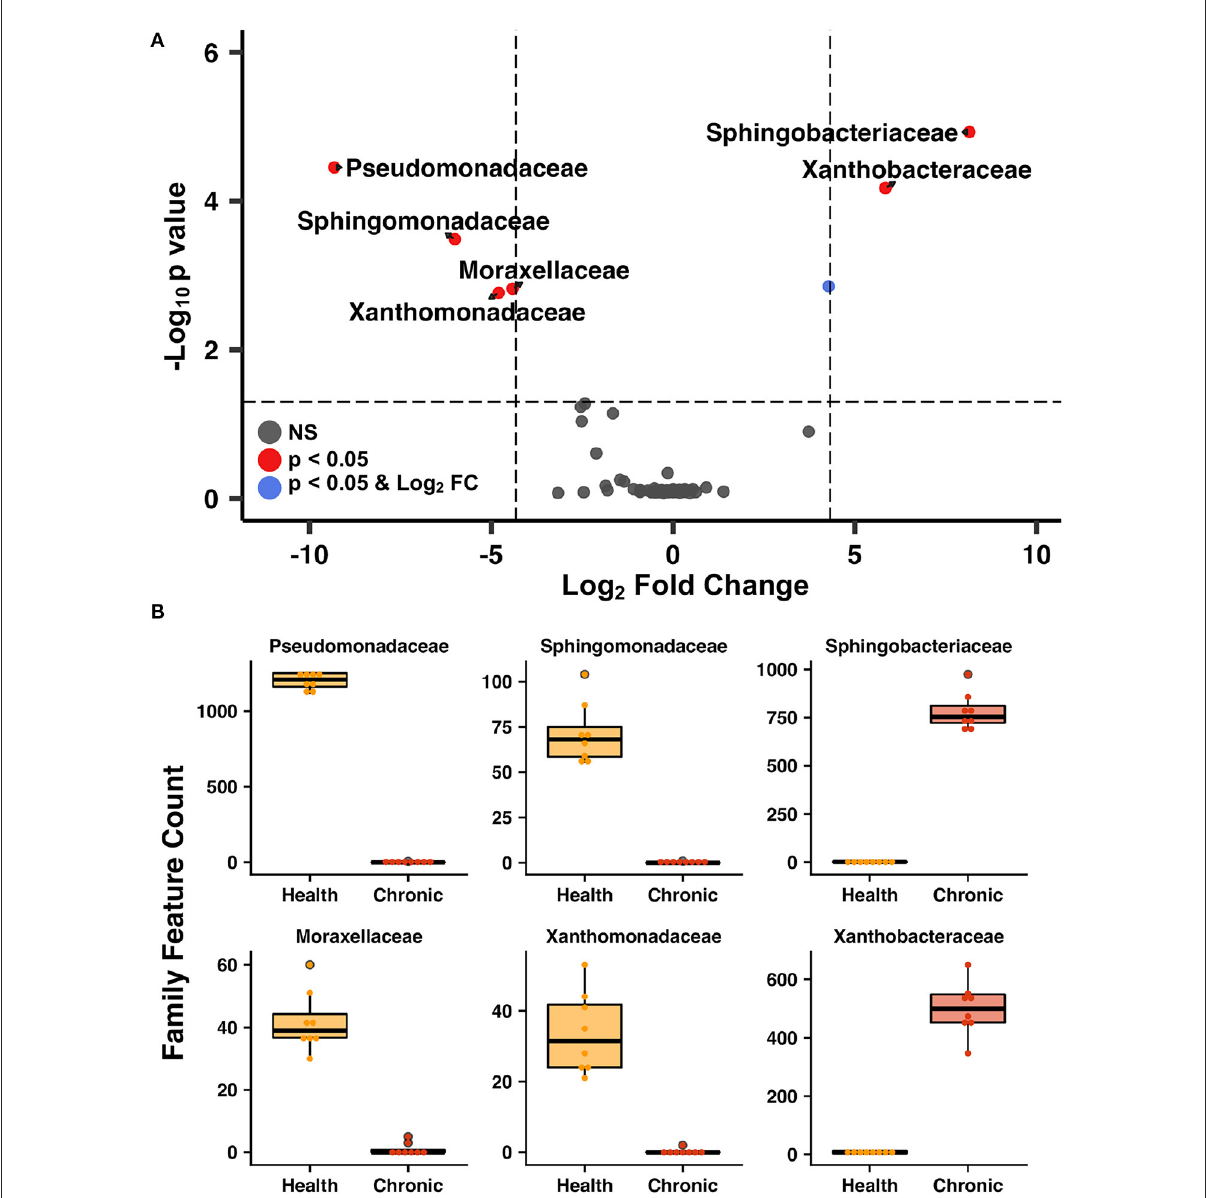
FIGURE5 Lower airway taxa that underwent most significant changes after asthma induction—Volcano plot (A) highlighting the most abundant families in the lower airways that underwent significant changes ( p < 0.05) and a 20-fold change in abundance as cats transitioned from health to chronic asthma. Box plots of bacterial taxa present at > 0.5% relative abundance (B) that underwent at least a 20-fold change as the lower airways transitioned from health to chronic